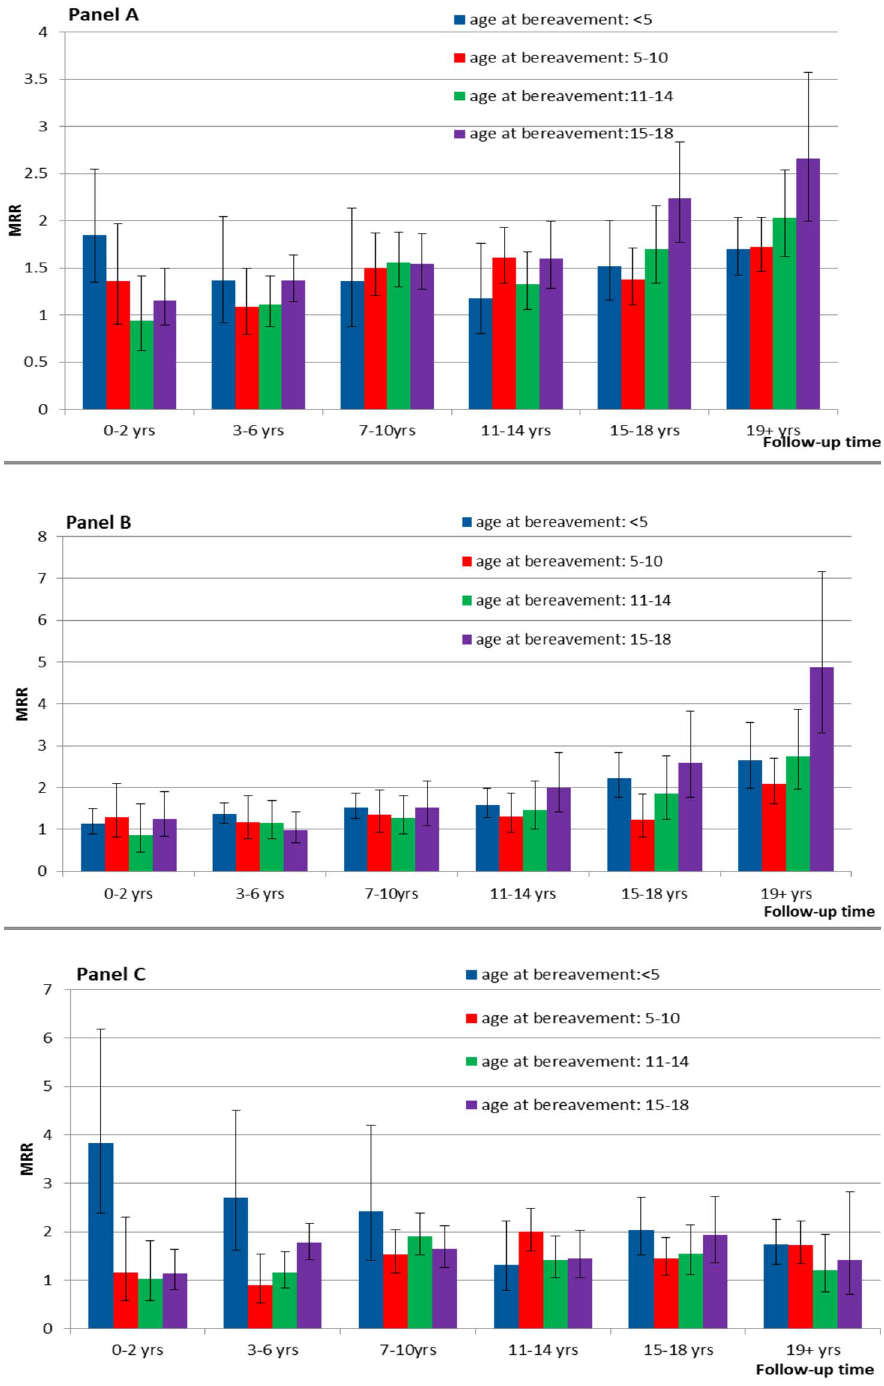
Figure 2. Mortality rate ratios after parental death in childhood by the length of follow-up time, according to child age at bereavement. (A) All-cause death MRRs over follow-up, by age at bereavement; (B) natural death MRRs over follow-up, by age at bereavement; (C) unnatural death MRRs over follow-up, by age at bereavement (MRRs were adjusted for country, age, sex, calendar year period, birth outcomes [birth weight, the Apgar score at 5 minutes, preterm birth], and maternal variables [age, parity, education, and social status]).